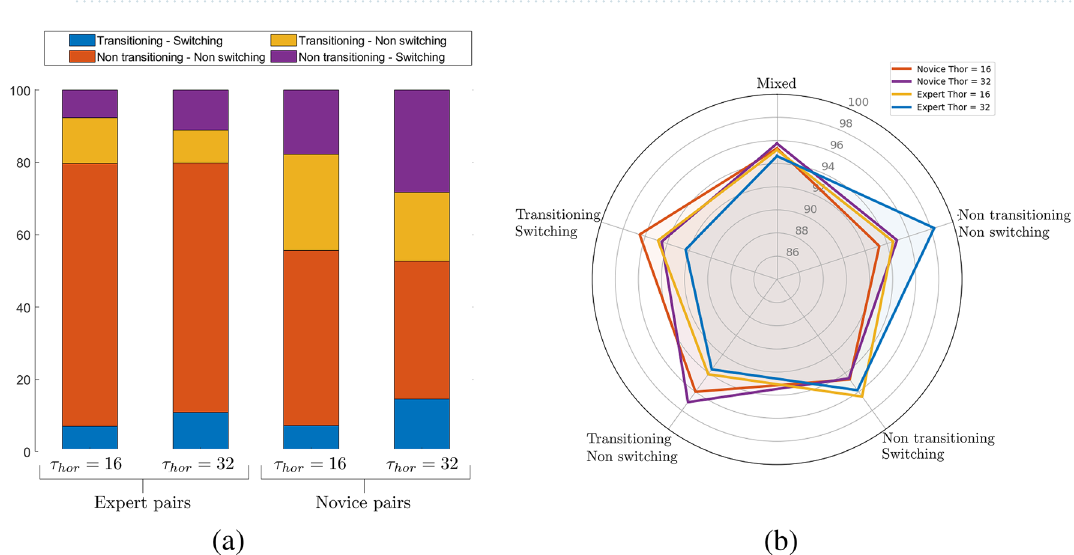
Figure 4. ( a ) Distribution of the different sub-categories of target selection (sample type) as a function of expertise level and prediction horizon. ( b ) The general (mixed) and sample specific accuracy of models trained using a uniform distribution of training samples (i.e., training set contained 25% of each sample type) as a function of expertise level and prediction horizon. Accuracy values ranged from 92.3 to 98.2%, with an overall mean accuracy of 95.23% while Mutual Information ranged from 66.6 to 93.5%, with an overall MI score of